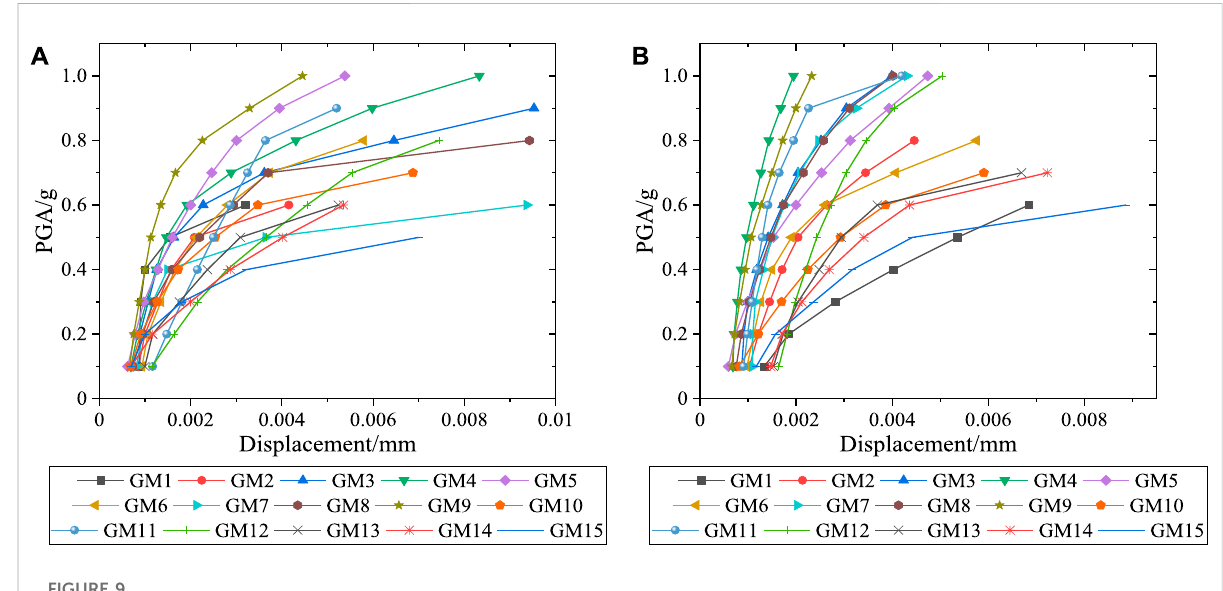
Maximum story drift of major structure: (A) Frame, (B) Core